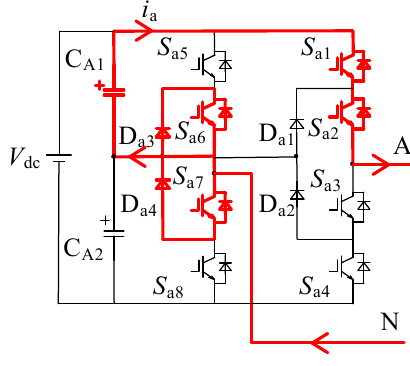
Figure 3. The circuit of pulse mapping 2.